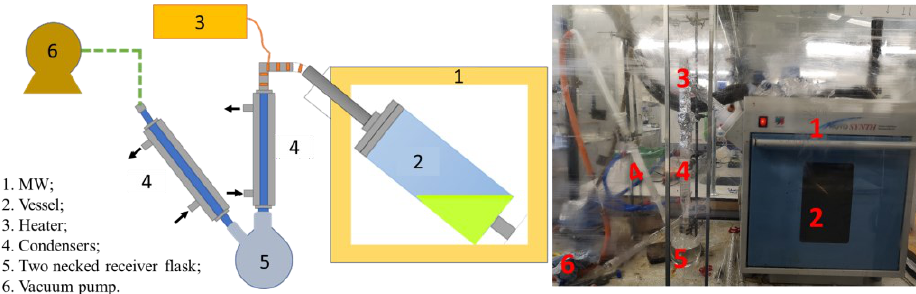
◦ rotative Milestone Roto SYNTH